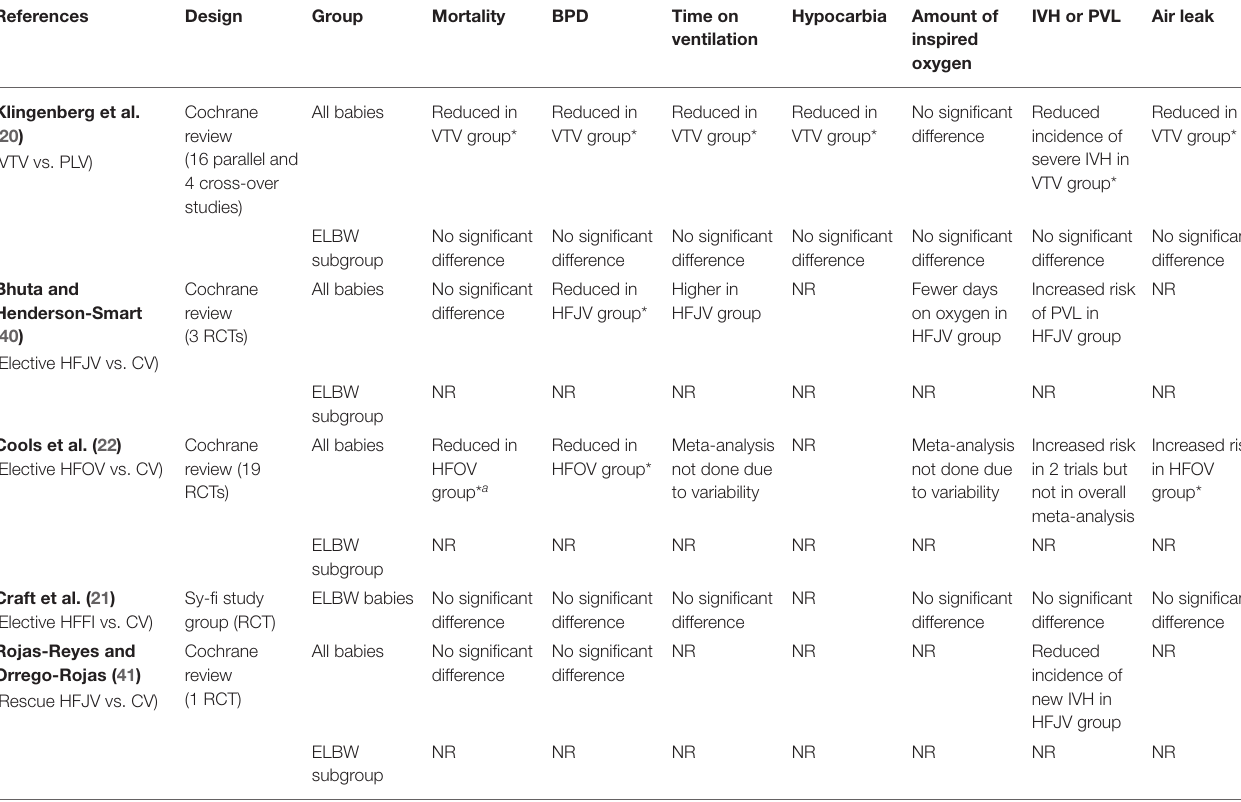
TABLE 1 | Characteristics and outcome measures of studies with different ventilation strategies in ELBW